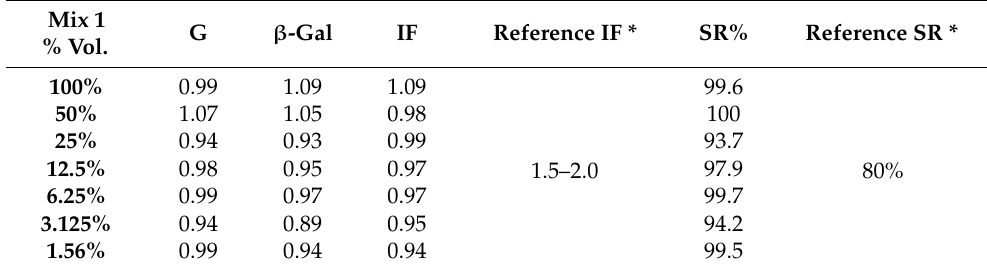
Table 3. The growth factor (G), activity of β -galactosidase ( β -gal), induction ratio (IF) and survival rate (SR%) values of Mix 1 on the engineered Escherichia coli. Mix